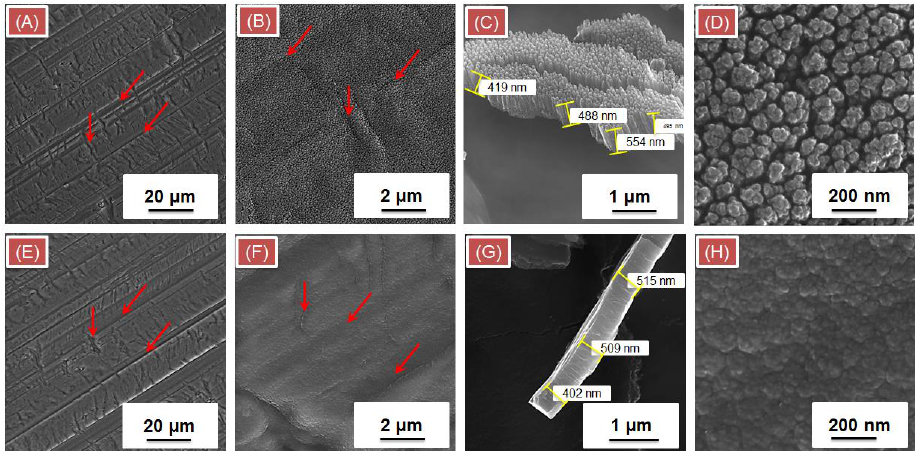
Figure A8. ( A – D ) Representative FE-SEM images of nitrogen-doped VOG coating prepared by the ICP CVD roll-to-roll technology at 0.5 Pa partial pressure of N 2 in {C 3 H 8 + Ar + N 2 } gas mixture (Sample N1). ( E – H ) Representative FE-SEM images of silicon-doped VOG at ¼ partial pressure of SiH 4 in {C 3 H 8 + Ar + SiH 4 } gas mixture (Sample S1).